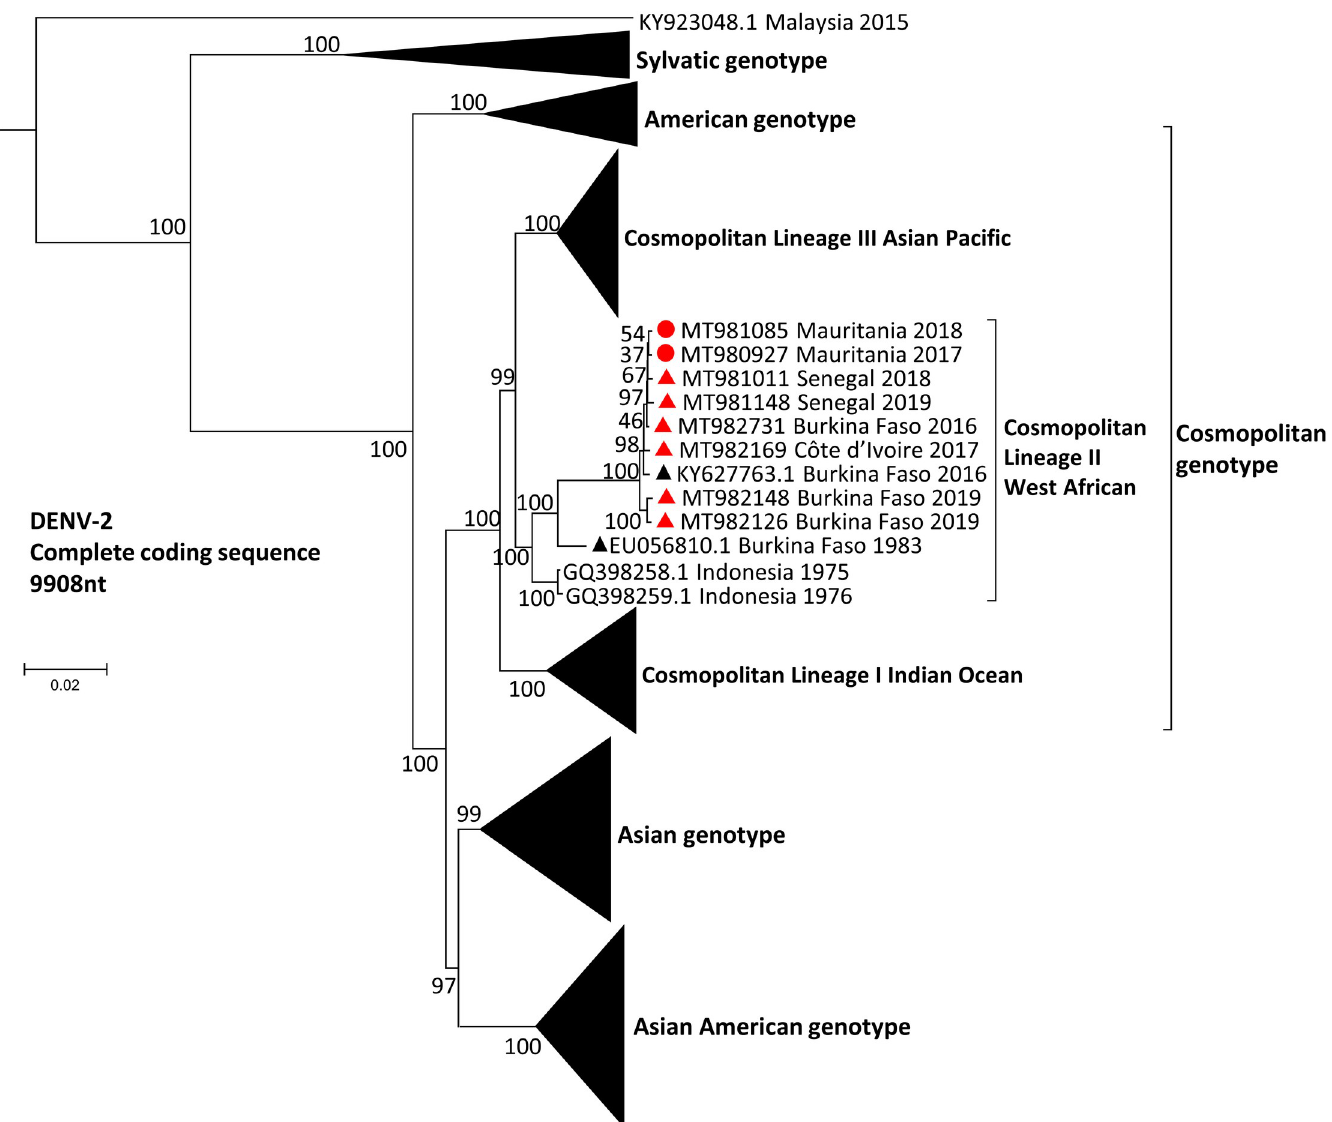
Fig 1. Maximum-likelihood phylogenetic tree based on complete genome of DENV-2 strains. DENV-2 strains from our data set are indicated by red circles for Mauritanian strains and red triangles for strains from other West African countries. Each strain is identified by its GenBank accession number, country of origin and year of sample collection. Reference DENV-2 genotyping alignment was completed with complete coding sequences available on GenBank selected based on nucleotide identity ( > 95%) or country of origin (Africa). Bootstrap support values (percentage of 1000 replicates) are shown at nodes. Scale bar indicates genetic distance (nucleotide substitutions per site). The tree was rooted with reference strains of DENV-1 (MH888331.1), DENV-3 (MH888333.1), and DENV-4 (MF004387.1) (not shown). Scale bar indicates nucleotide substitutions per site. DENV, dengue virus.